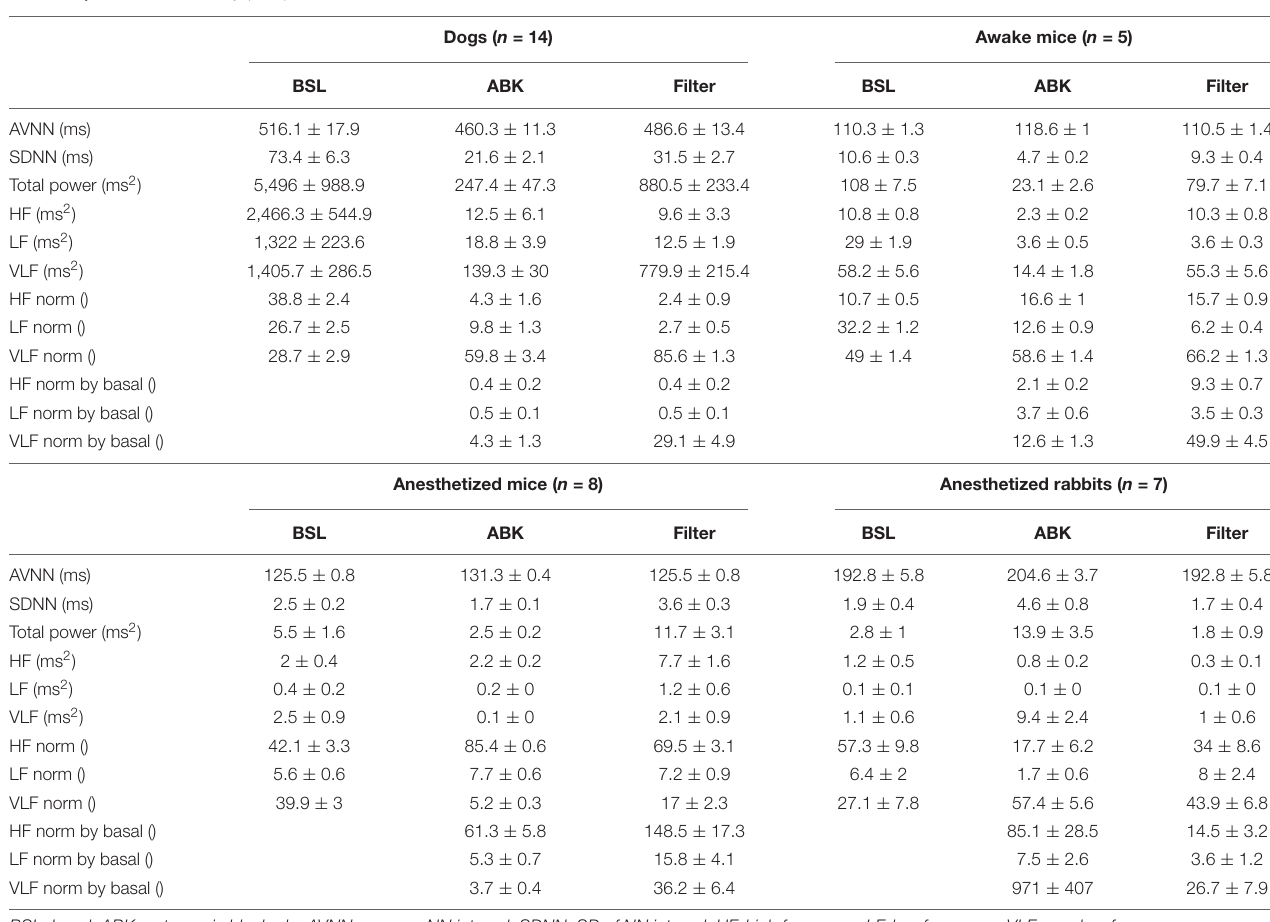
TABLE 1 | Heart rate variability (HRV) measures for different